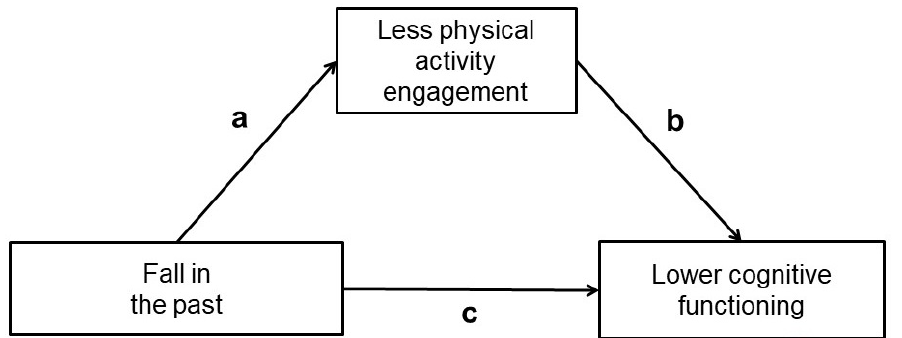
Figure 1. Illustration of the general analytical design of the mediation models applied to investigate whether the relation of having experienced a fall in the past to lower performance in the cognitive functioning measures was mediated via less physical activity engagement as a cognitive reserve contributor.